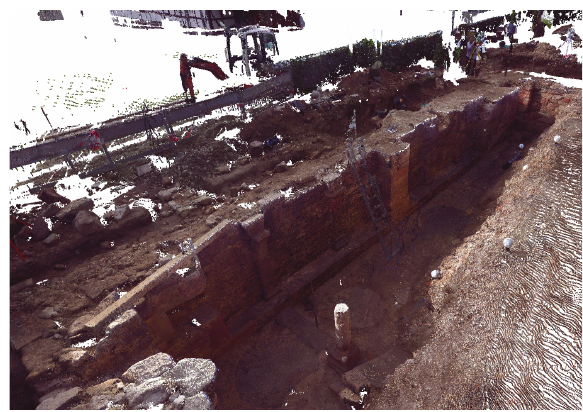
Figure 5: Visualisation of a 3D point